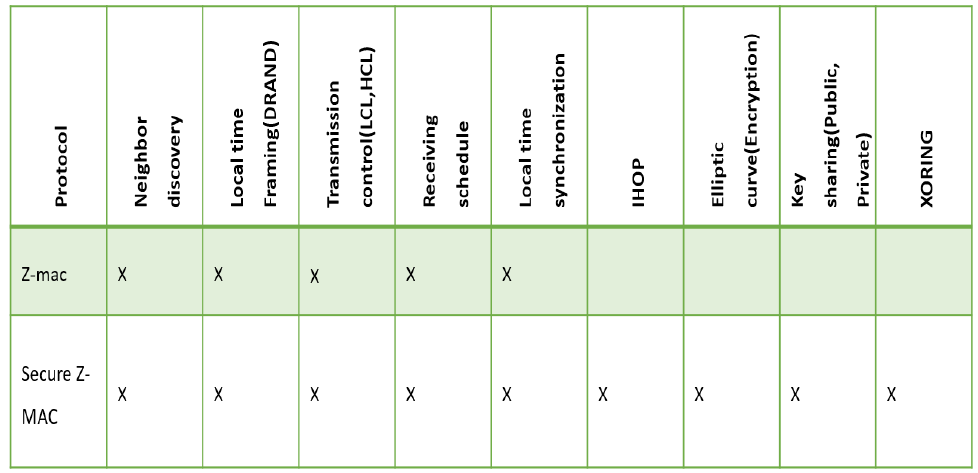
Figure 14. Comparison of the stages in Z-MAC and the secure Z-MAC protocol.